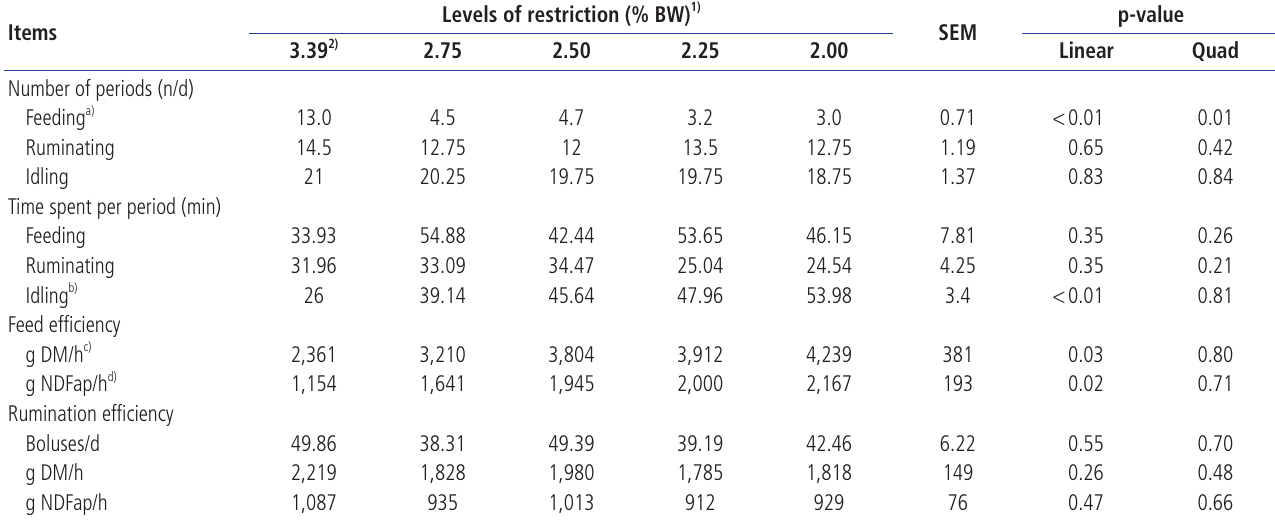
Table 5. Number of periods and average time spent per period on the feeding, ruminating, and idle activities by F1 Holstein/Zebu cows under quantitative feed restriction in the middle third of lactation Items